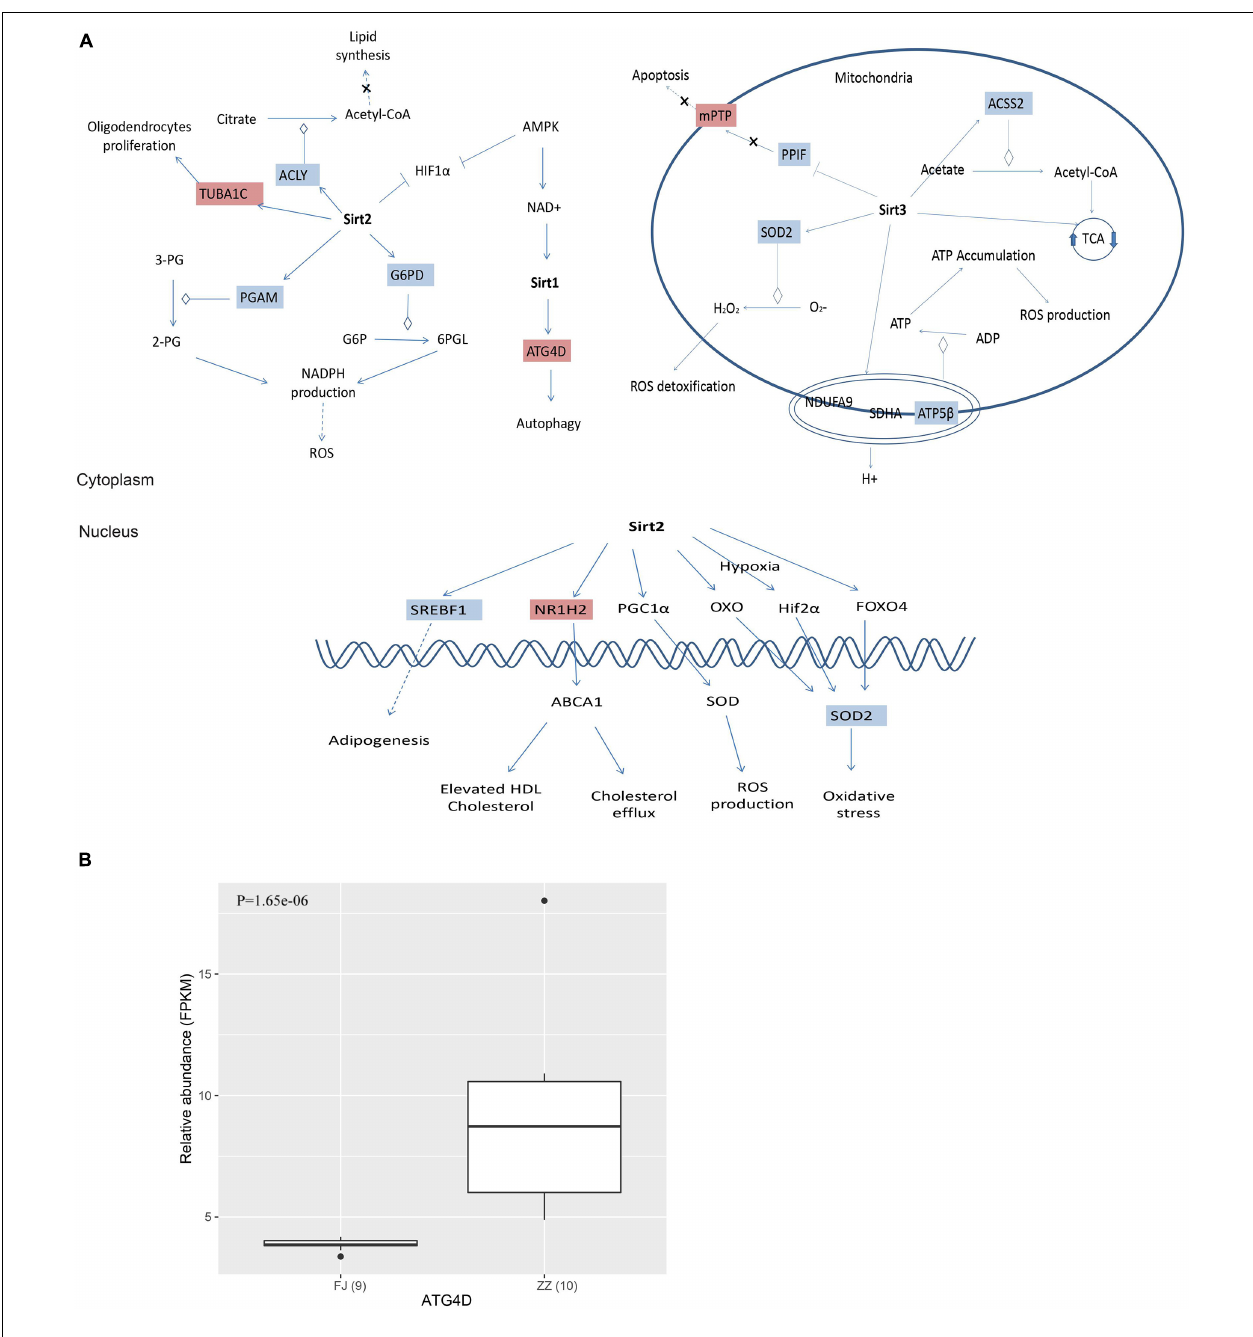
FIGURE 7 | (A) The differentially expressed genes (DEGs) were invovled in Sirtuin signaling pathway. Sirtuins are class III histone deacetylase enzymes that use NAD + as a co-substrate for their enzymatic activities. There are 15 DEGs involved in the Sirtuin pathway, and the DEGs are associated with energy metabolism, oxidative stress and apoptosis. (B) ATG4D associated with autophagy was significant differential expressed between the infected group and the healthy group.